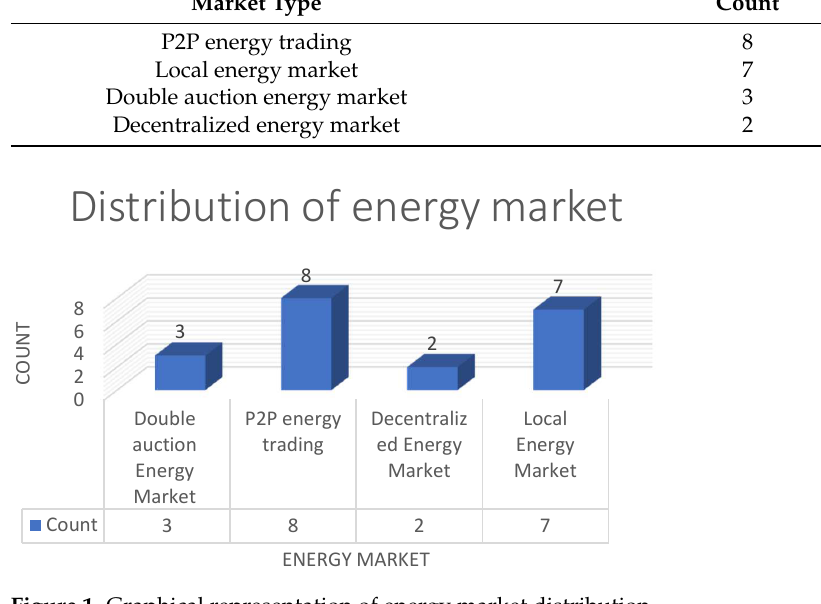
Figure 1. Graphical representation of energy market distribution .